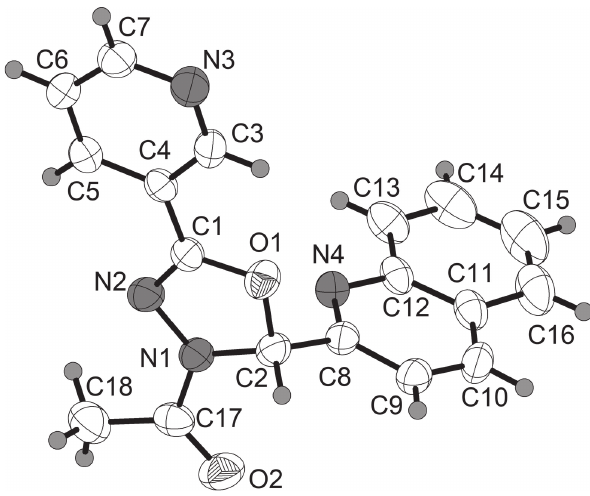
Table 2: Fractional atomic coordinates and isotropic or equivalent isotropic displacement parameters (Å 2